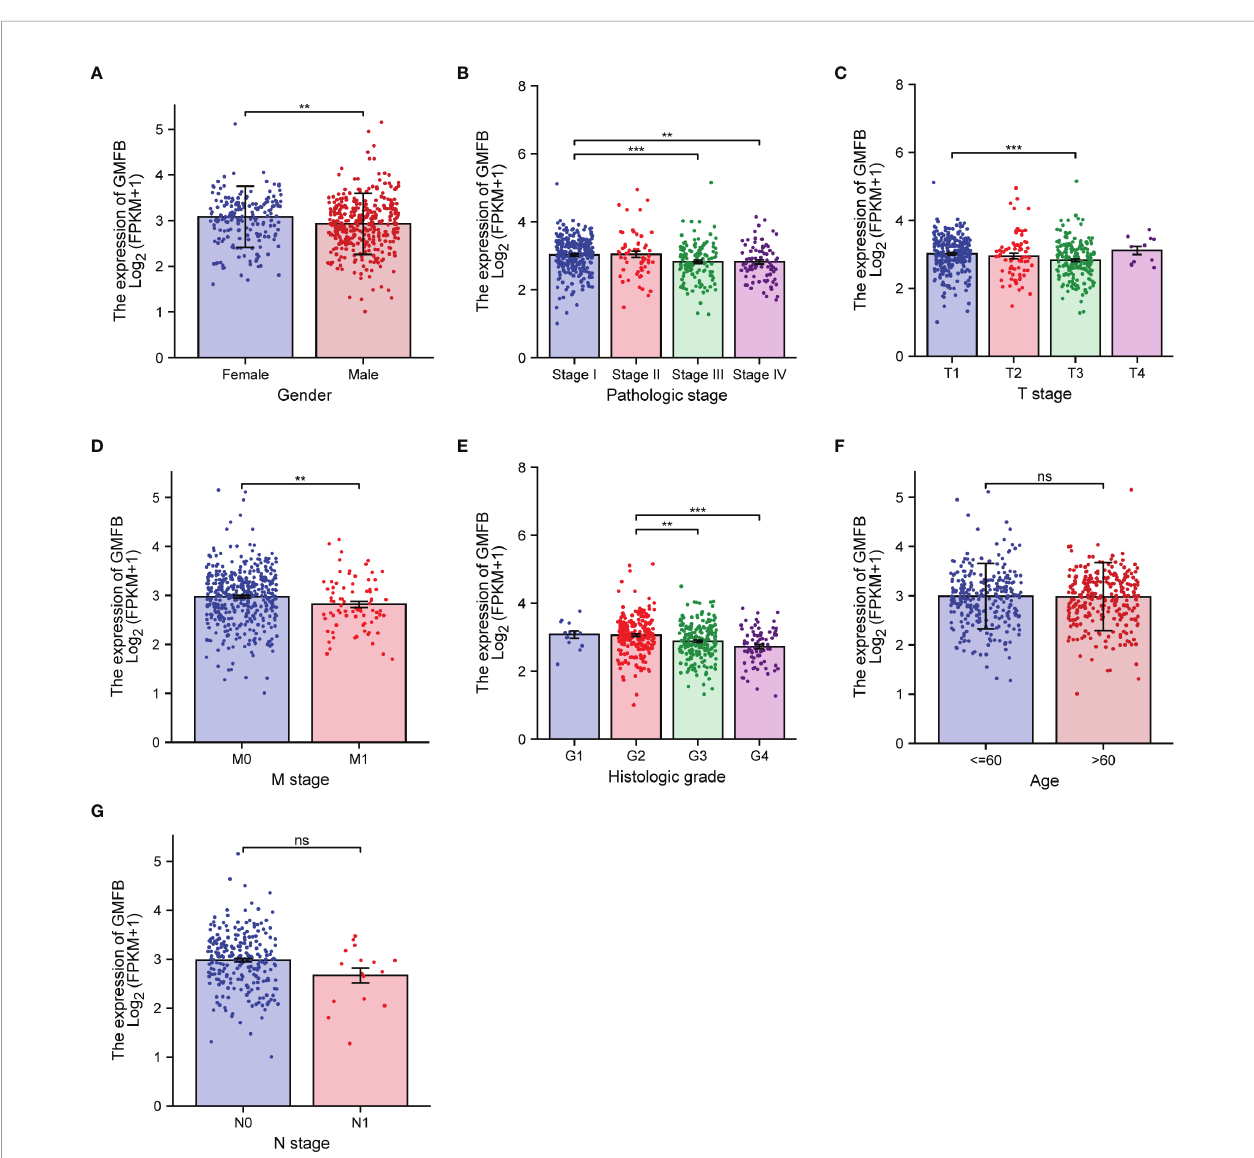
FIGURE 2 | Association between the expression of Gmfb and the key clinicopathological characteristics of kidney renal clear cell carcinoma (KIRC). (A) Gender. (B) Pathologic grade. (C) T stage. (D) M stage. (E) Histologic grade. (F) Age. (G) N stage. **p < 0.01, ***p < 0.001, ns not signi fi